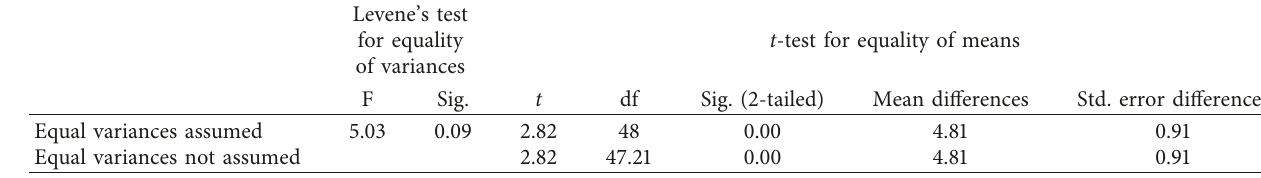
Table 4: Inferential statistics of the two groups on the reading posttest.